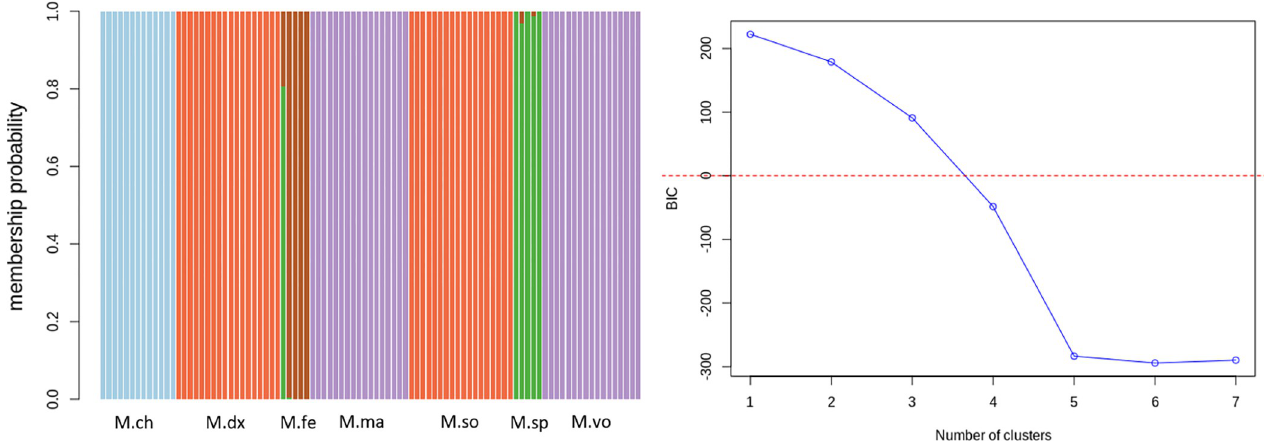
Fig 8. Cluster membership classification of Macrobrachium species and the Bayesian information criterion (BIC) plot obtained from a reduced set of informative or ‘private SNPs’ (N = 72 SNPs) using Adegenet package [36] assuming five clusters (K = 5). Each bar in the admixture plot (left) represents an individual: M.ch –M . chevalieri; M.dx –M . dux; M.so –M . sollaudii; M.fe –M . felicinum; M.sp –M . sp; M.ma –M . macrobrachion; M.vo –M . vollenhovenii .